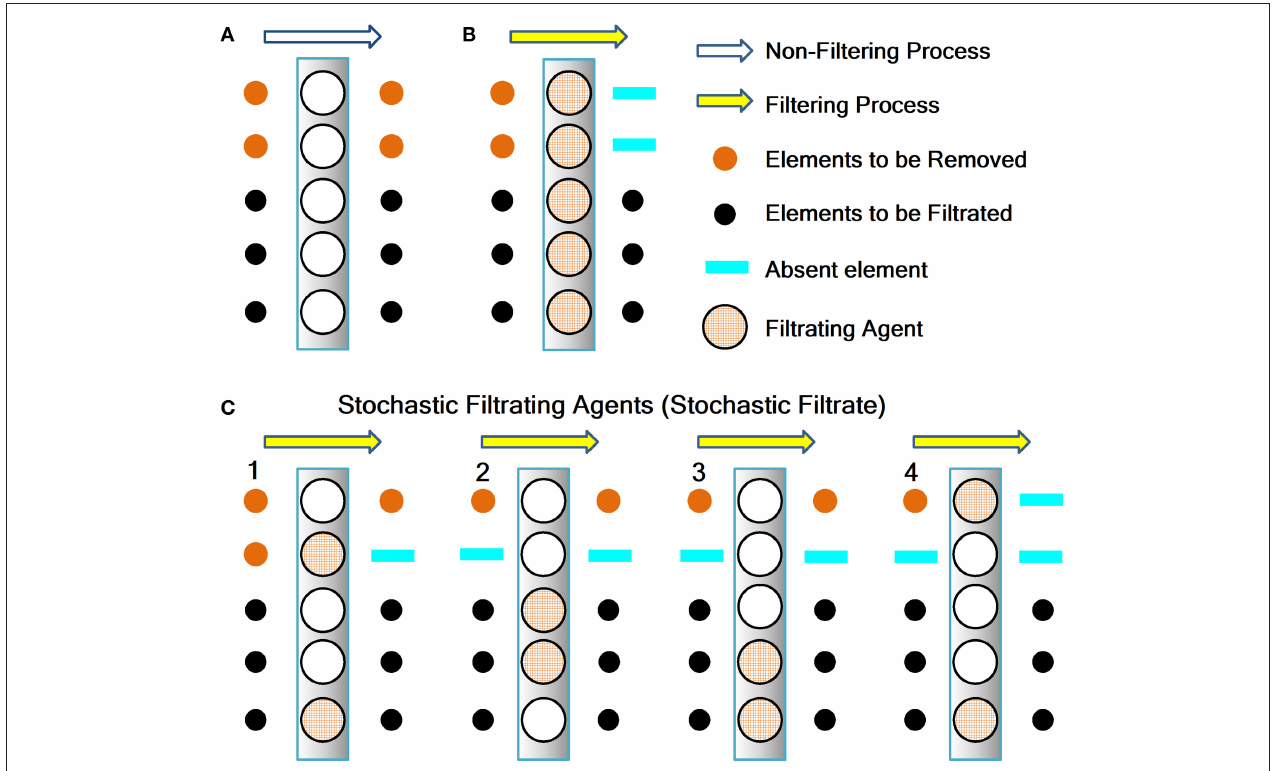
FIGURE 1 | Scheme to explain the mathematical concept of the stochastic filtrate. (A) Absence of filtrating agent. (B) Complete filtrating agent. (C) Stochastic filtrate. We can use the stochastic method illustrated in (C) to obtain the deterministic processes shown in (A,B) . Additional explanation is in the text. The elements to be removed are the “filtride” and the elements to be filtered are the